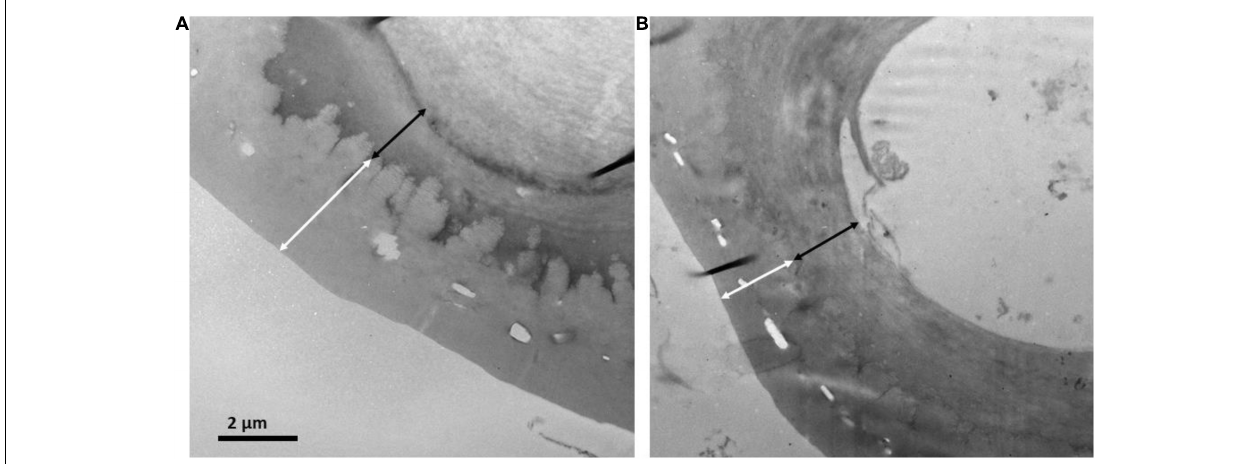
FIGURE 2 | Transmission electron micrographs of the cuticle and outer cell wall for needles of P. uncinata grown at (A) Forest and (B) Krummholz populations. The white arrows represent cuticle thickness and the black arrows represent cell wall